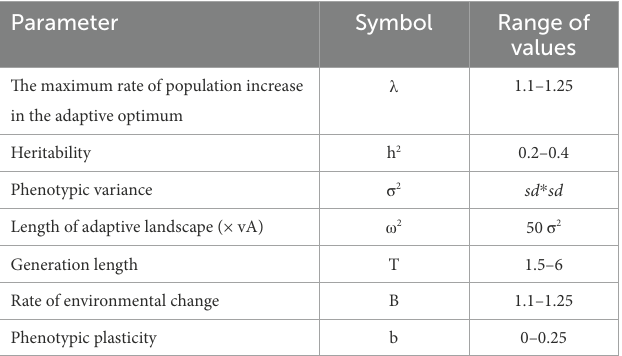
TABLE 1 Population and genetics parameters used in the eco-evolutionary model for evolutionary rescue and adaptation in amphibians of the world. Parameter Symbol Range of